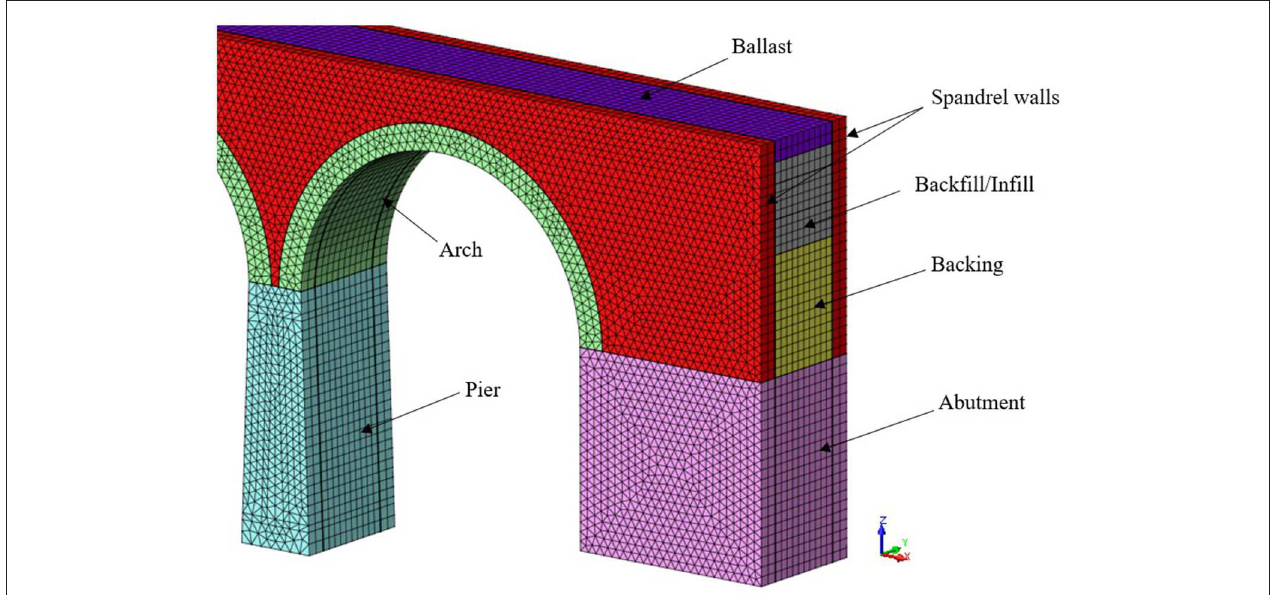
FIGURE 5 | Specific detailing of the 3D FEM bridge model under study.